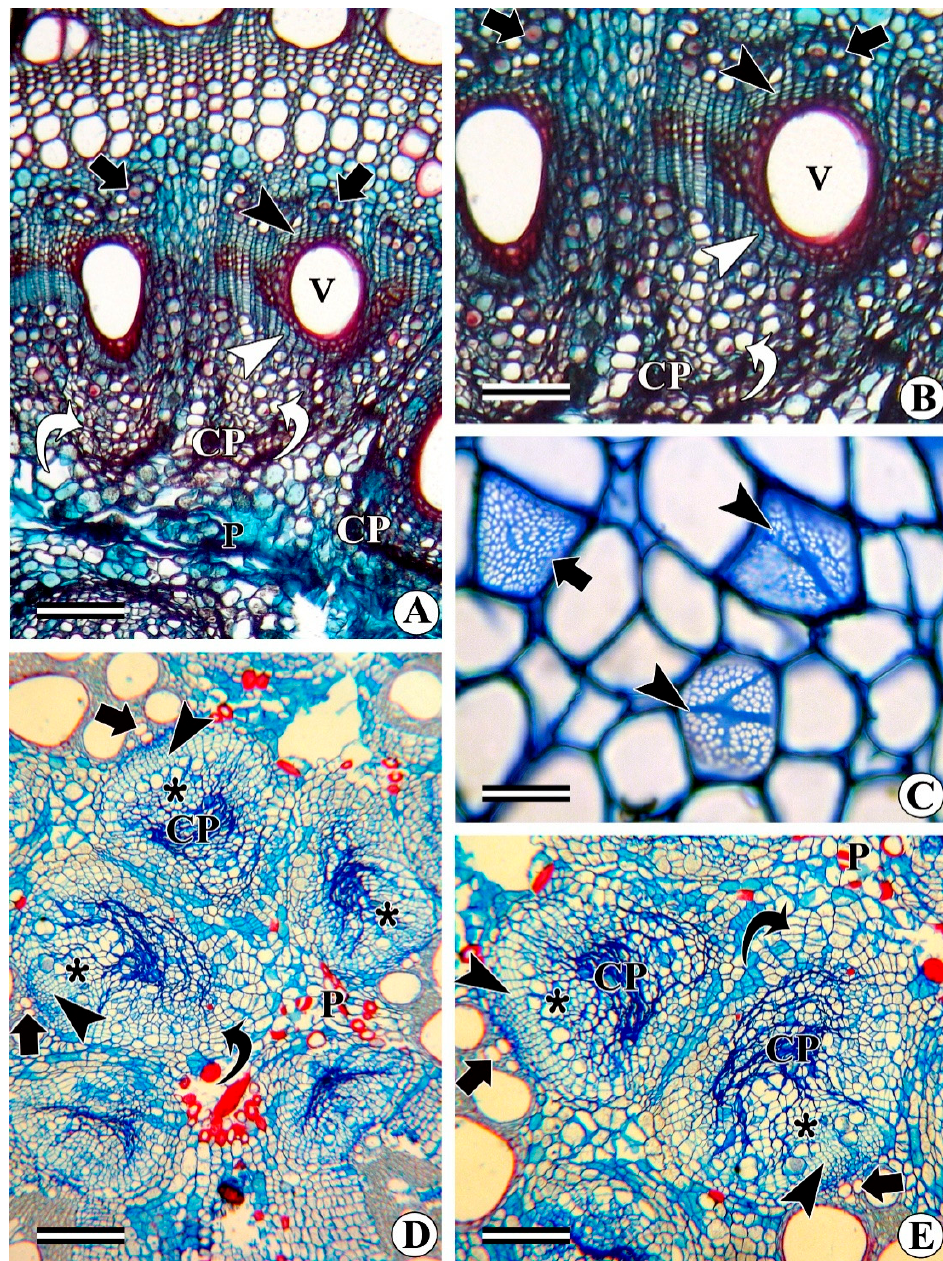
Figure 12. Transverse view of mature stems showing intraxylary phloem cambium ( A , B ), the structure of sieve elements, and phloem of bicollateral vascular bundles. ( A ) Intraxylary cambia in Ipomoea turbinata. An outer cambium (black arrowhead) and phloem developed from it (black arrow). An inner cambium (white arrowhead) and phloem formed from it (curved arrow). ( B ) Enlarged view of I. turbinata. Figure legend follows a similar indication. ( C ) Structure of sieve plates in I. turbinata. Note the differences (arrows and arrowheads). ( D ) Bicollateral vascular bundles in thick stems of Coccinia grandis showing additional secondary phloem (asterisk) developed on the margin of the protoxylem (arrow). Intraxylary phloem cambium (arrowheads) and meristematic rings that formed later that encircle the phloem (curved arrows). ( E ) Enlarged view of Figure 12D. Figure legend follows a similar indication. Abbreviations : CP = crushed intraxylary phloem; P = pith cells, V = vessel. Scale bars : A, D = 200 µm, B, E = 100 µm, C = 20 µm.